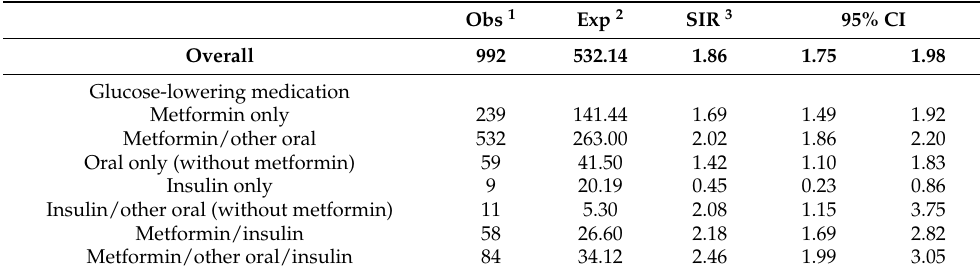
Table 2. EC risk by glucose-lowering medications among women with T2DM in Lithuania.